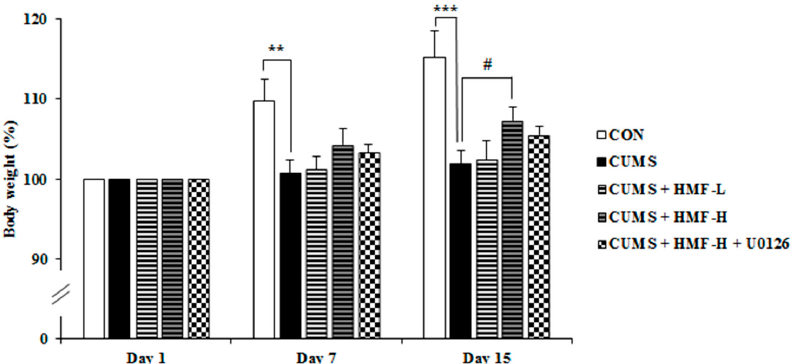
Figure 3. Effects of chronic unpredictable mild stress and HMF treatments on body weight changes on Days 1, 7, and 15. Values are means ± SEM ( n = 12–16). Symbols show significant differences between the following groups: CON vs. CUMS (** p < 0.01, *** p < 0.001, the Student’s t -test) and CUMS vs. CUMS + HMF-H ( # p < 0.05, one-way ANOVA followed by the post-hoc Williams multiple comparison test).